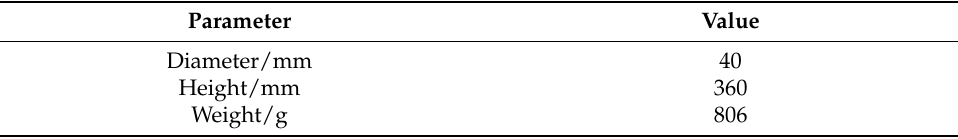
Table 2. Main parameters of parachute.